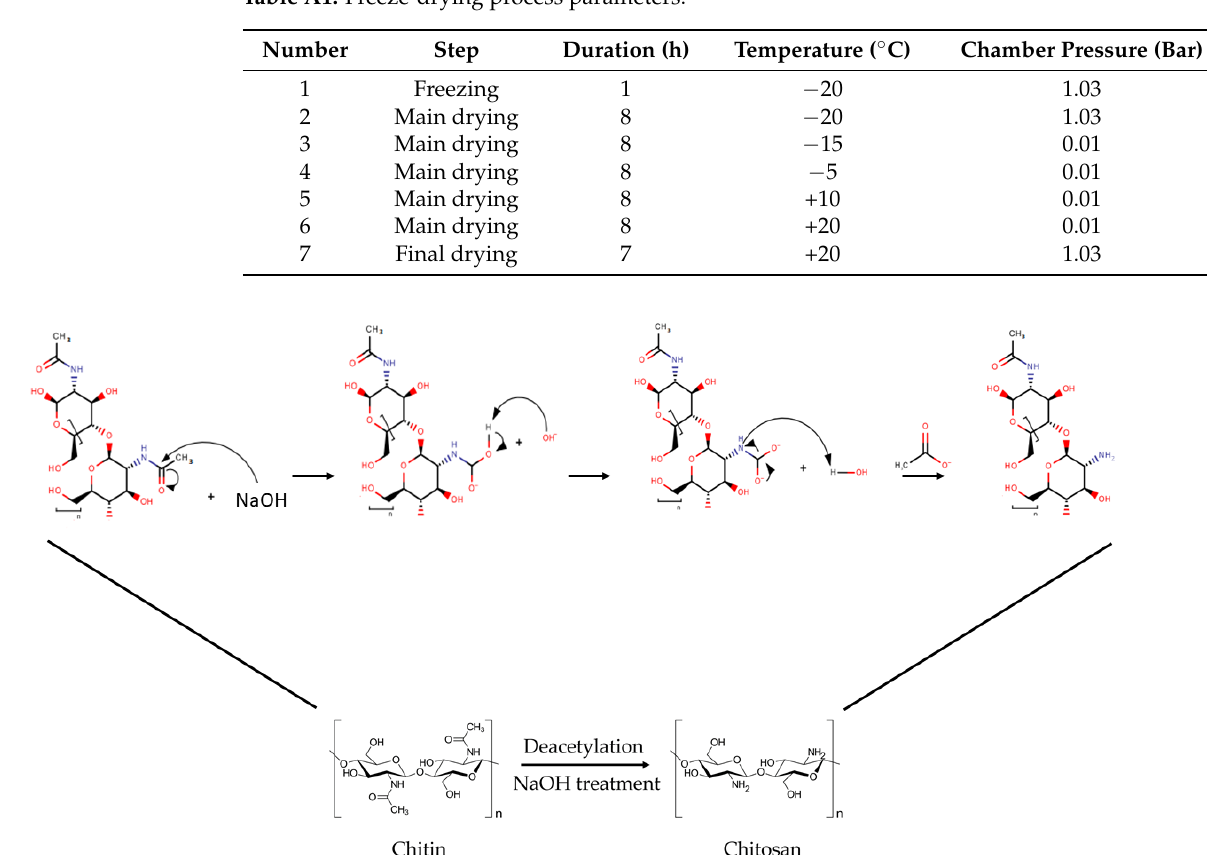
Figure A2. Calibration curve first derivative UV method; the average of three measurements is shown; error bars are indicated but mostly fall within the data points.